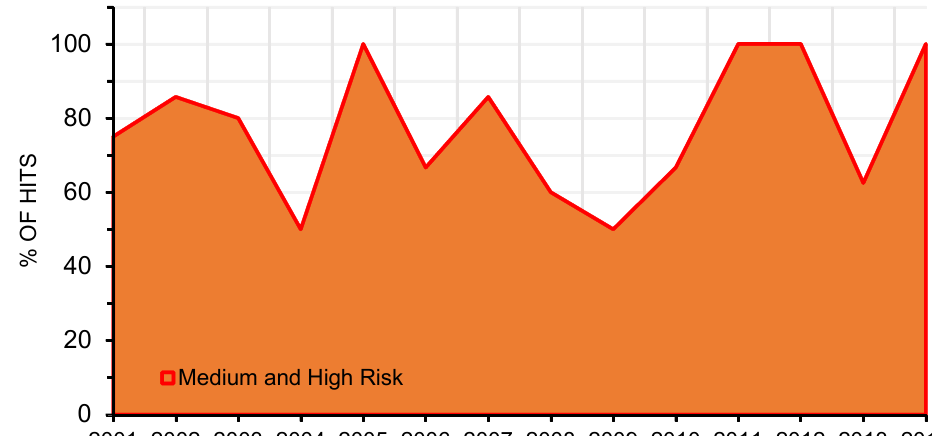
Figure 7. Percentage of hits from the total of hotspots observed in the medium and high risk classes from 2001 to